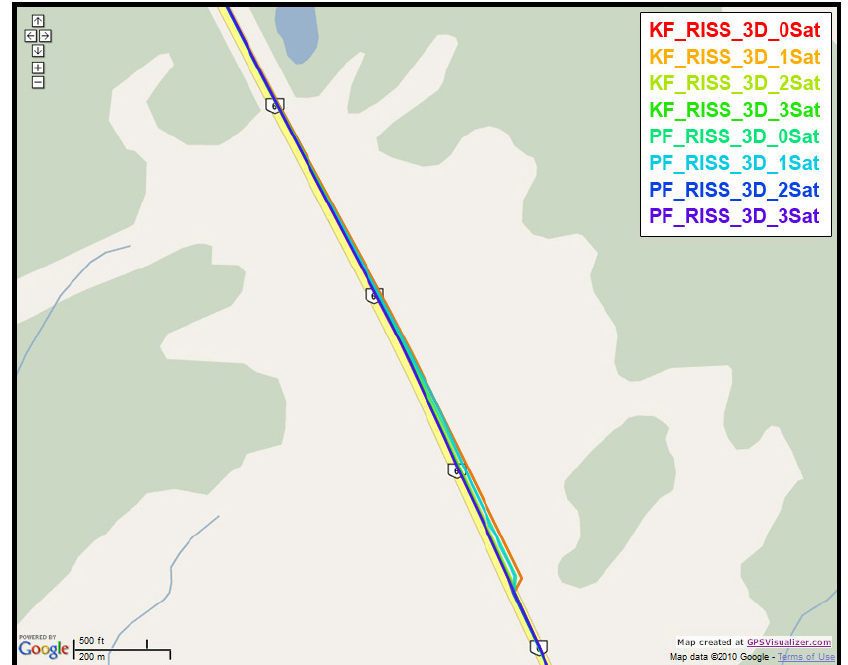
Figure 8. Performance during the simulated GPS outage #7 of the first